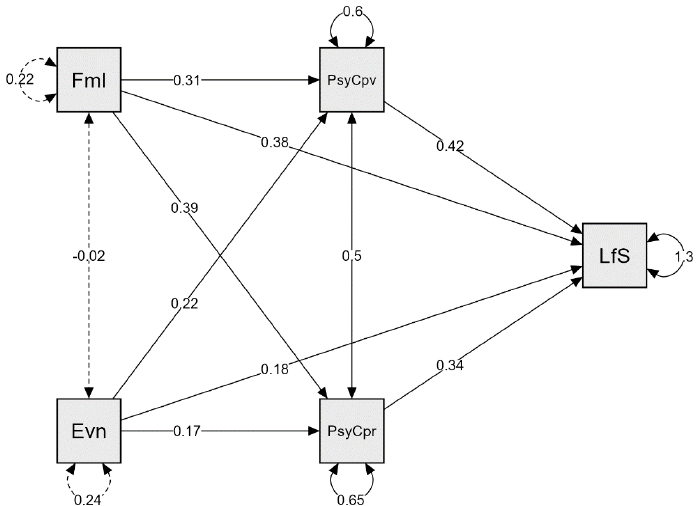
Figure 1. Mediation analysis: path plot in the total sample, the role of psychological capital as a mediator. Fml: spending time with family; Evn: participating in events; PsyCpv: PsyCap overall; PsyCpr: PsyCap relationship; LfS: life satisfaction.